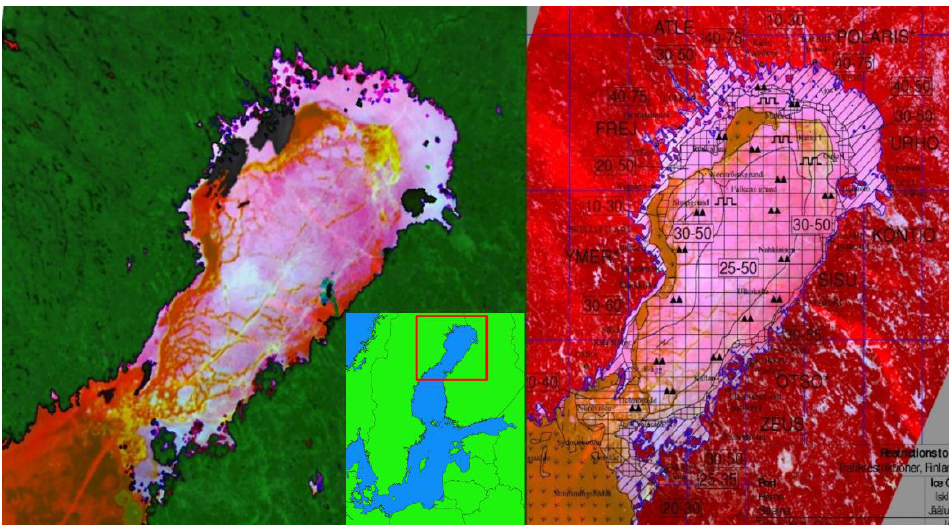
Figure 1. Comparison of sea ice classification results using AVHRR data ( left , land masking applied) and SLSTR data ( right , no land masking) of 13 April 2018 in northern Bothnian Sea and Bothnian Bay as indicated by the overview map (Refer to Table 2 for colour legend). In the section on the right, the corresponding ice chart by SMHI is overlaid.